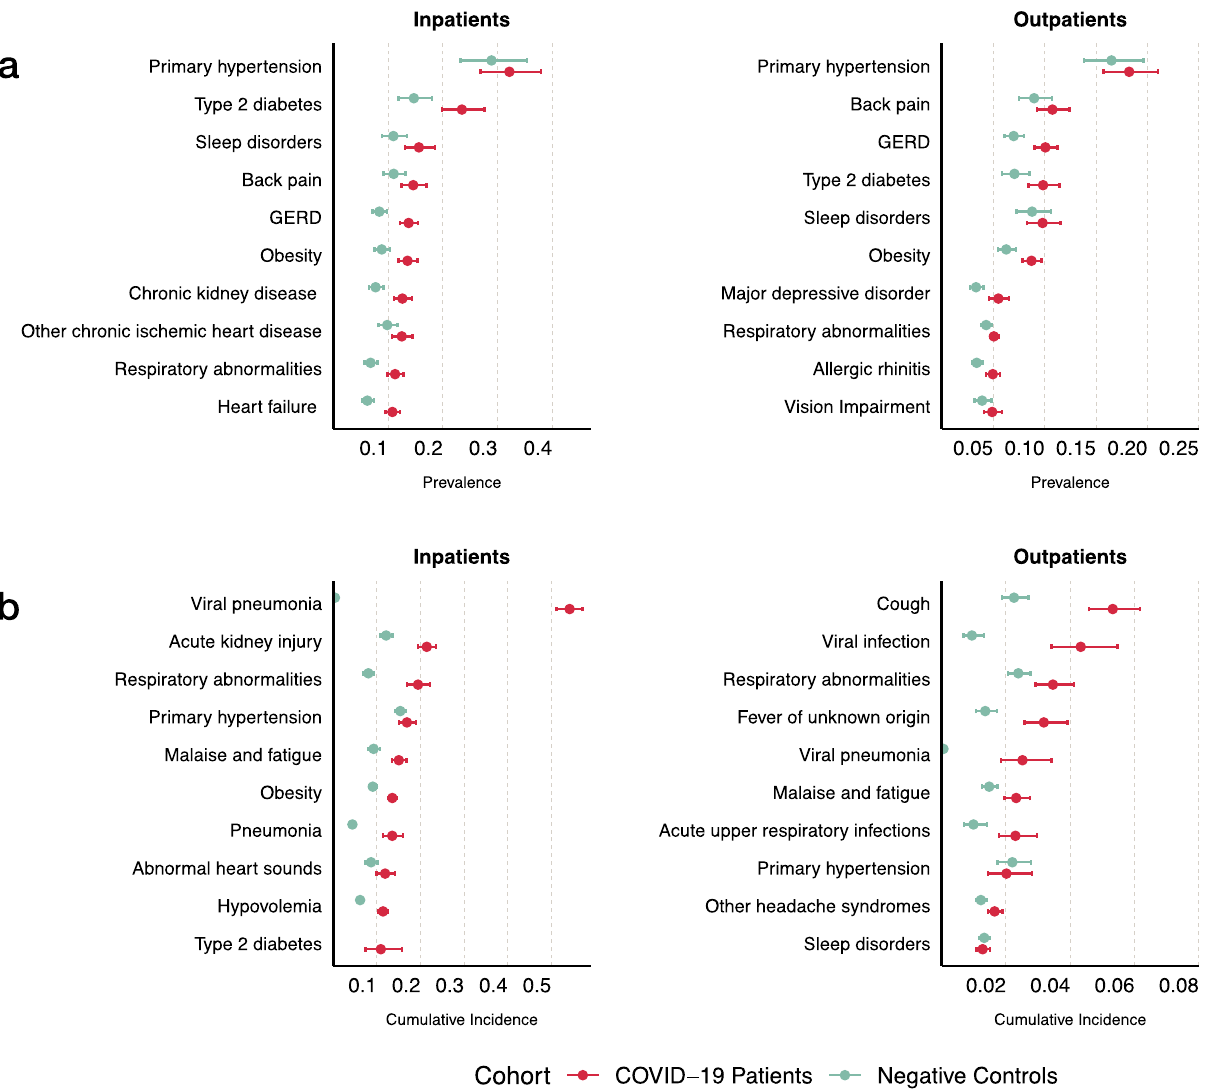
Fig. 2 Clinical characteristics of the study population. a Most prevalent preexisting conditions in COVID-19 patients compared to the controls strati fi ed by hospitalization status. b Conditions with the highest cumulative incidence during the acute stage up to 29 days after initial